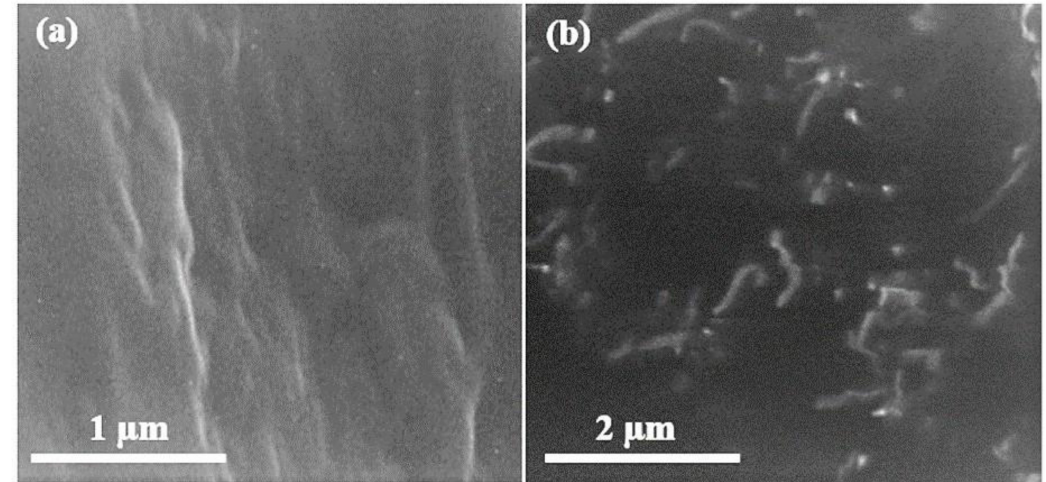
Figure 6. Scanning electron microscopy images of ( a ) cured urea–formaldehyde resin and ( b ) cured UF–GO nanofillers at 25